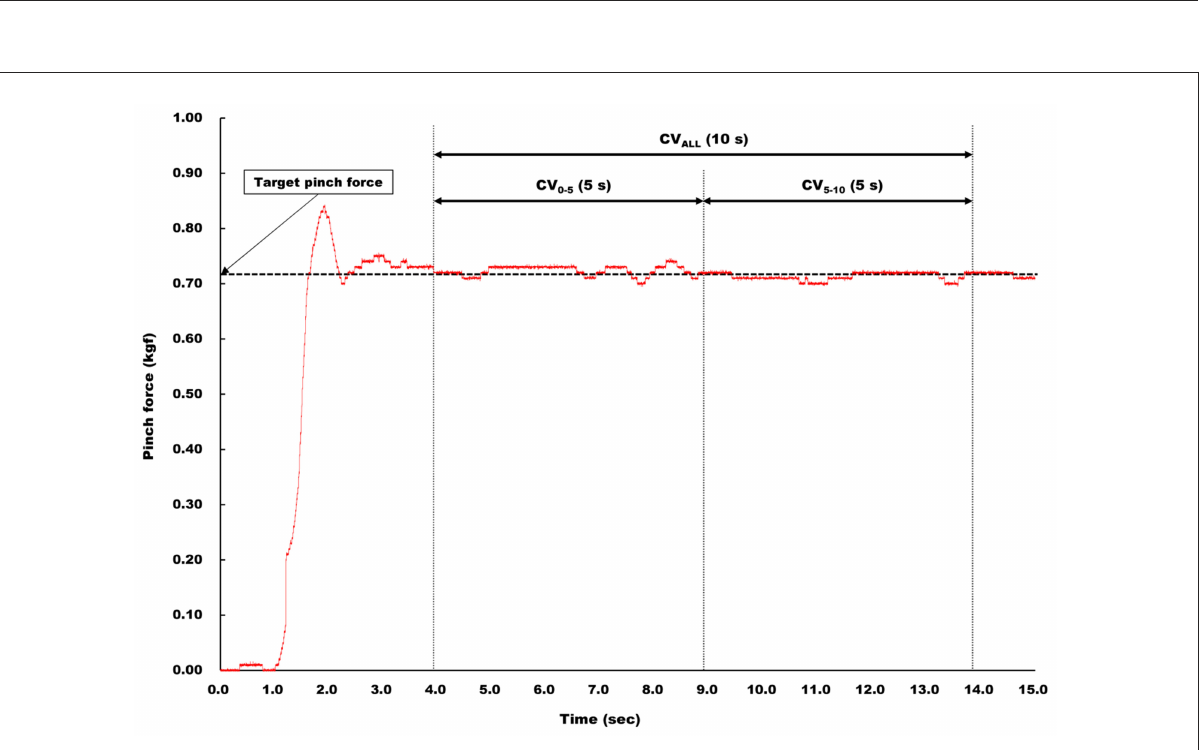
FIGURE2 Analysis of force steadiness. Force steadiness was quantified as CV for three selected segments, termed CV ALL , CV 0 − 5 , and CV 5 − 10 , respectively, from the 10s plateau of each pinch task. The duration of CV ALL was 10s, and that for CV 0 − 5 and CV 5 − 10 was